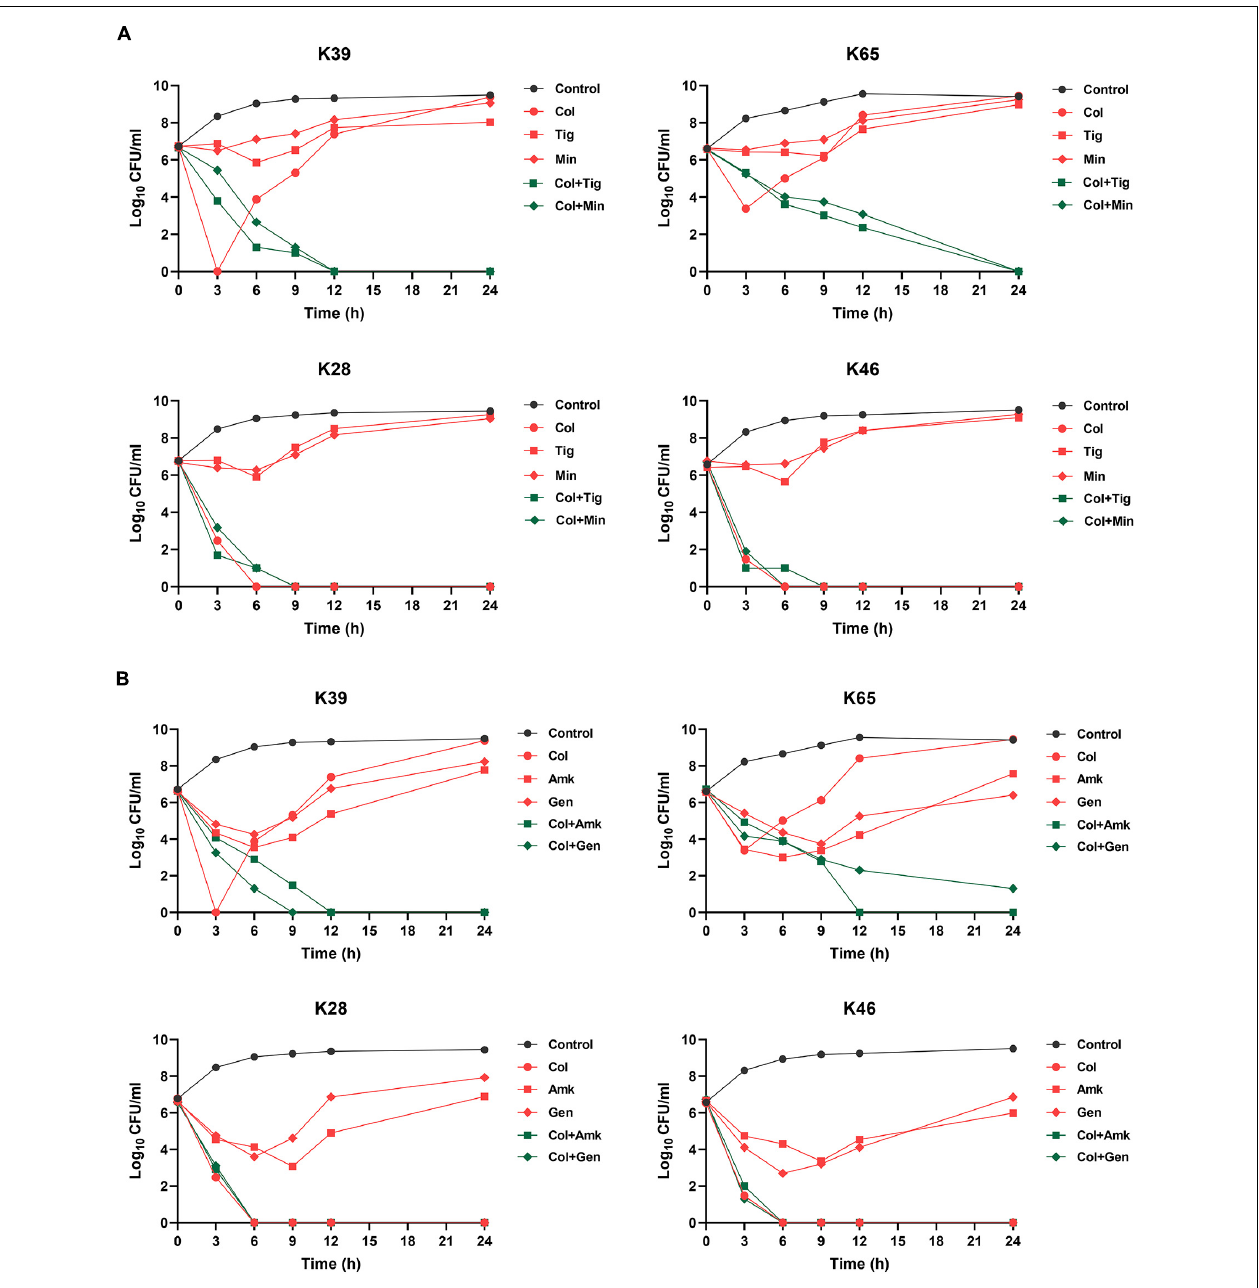
FIGURE 5 | Time-kill curves of different combination therapies against representative CR-KP strains with (K39 and K65) or without (K28 and K46) colistin heteroresistance. (A) Time-kill curves of colistin combined with tigecycline or minocycline against representative CR-KP strains; Col, colistin; Tig, tigecycline; Min, minocycline. (B) Time–kill curves of colistin combined with amikacin or gentamicin against representative CR-KP strains; Amk, amikacin; Gen,